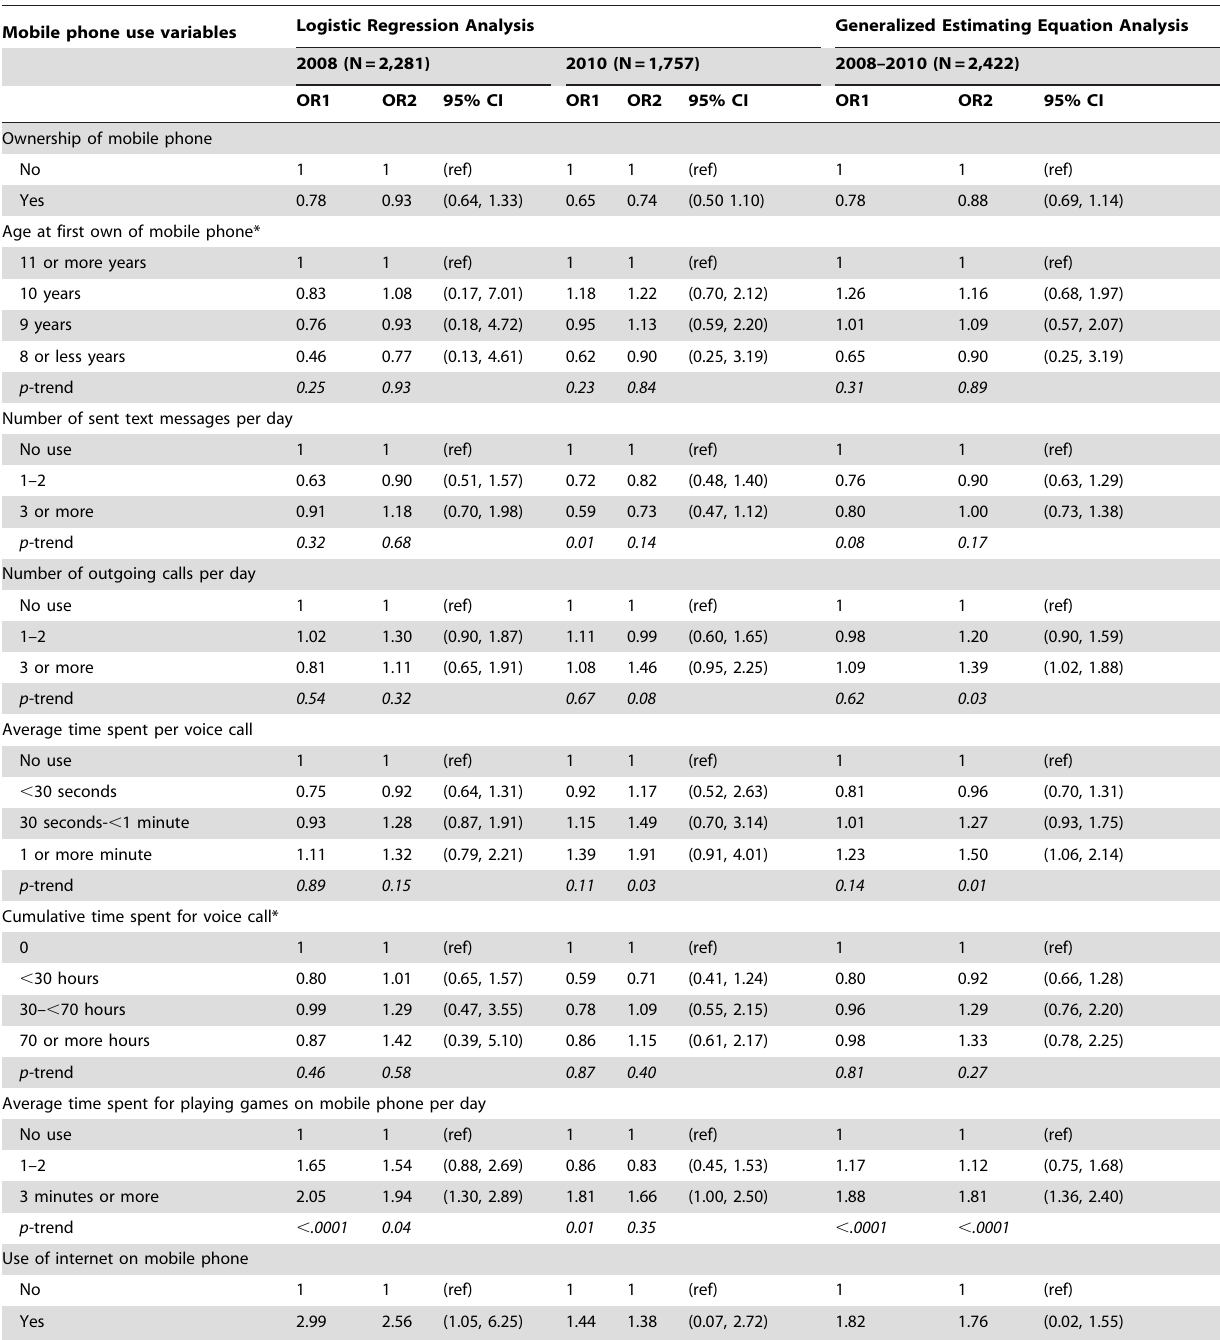
Table 2. Association between Mobile Phone Use and ADHD in Children in 2008 and 2010, Korea, the CHEER study.